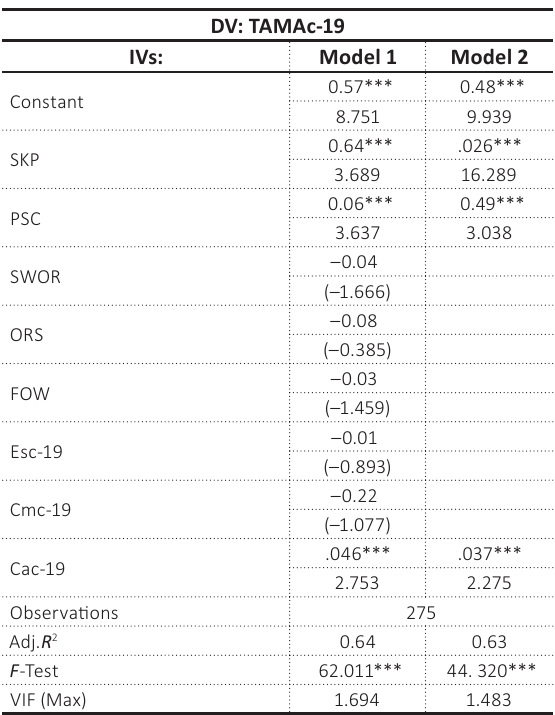
Table 4. OLS regression for Equation